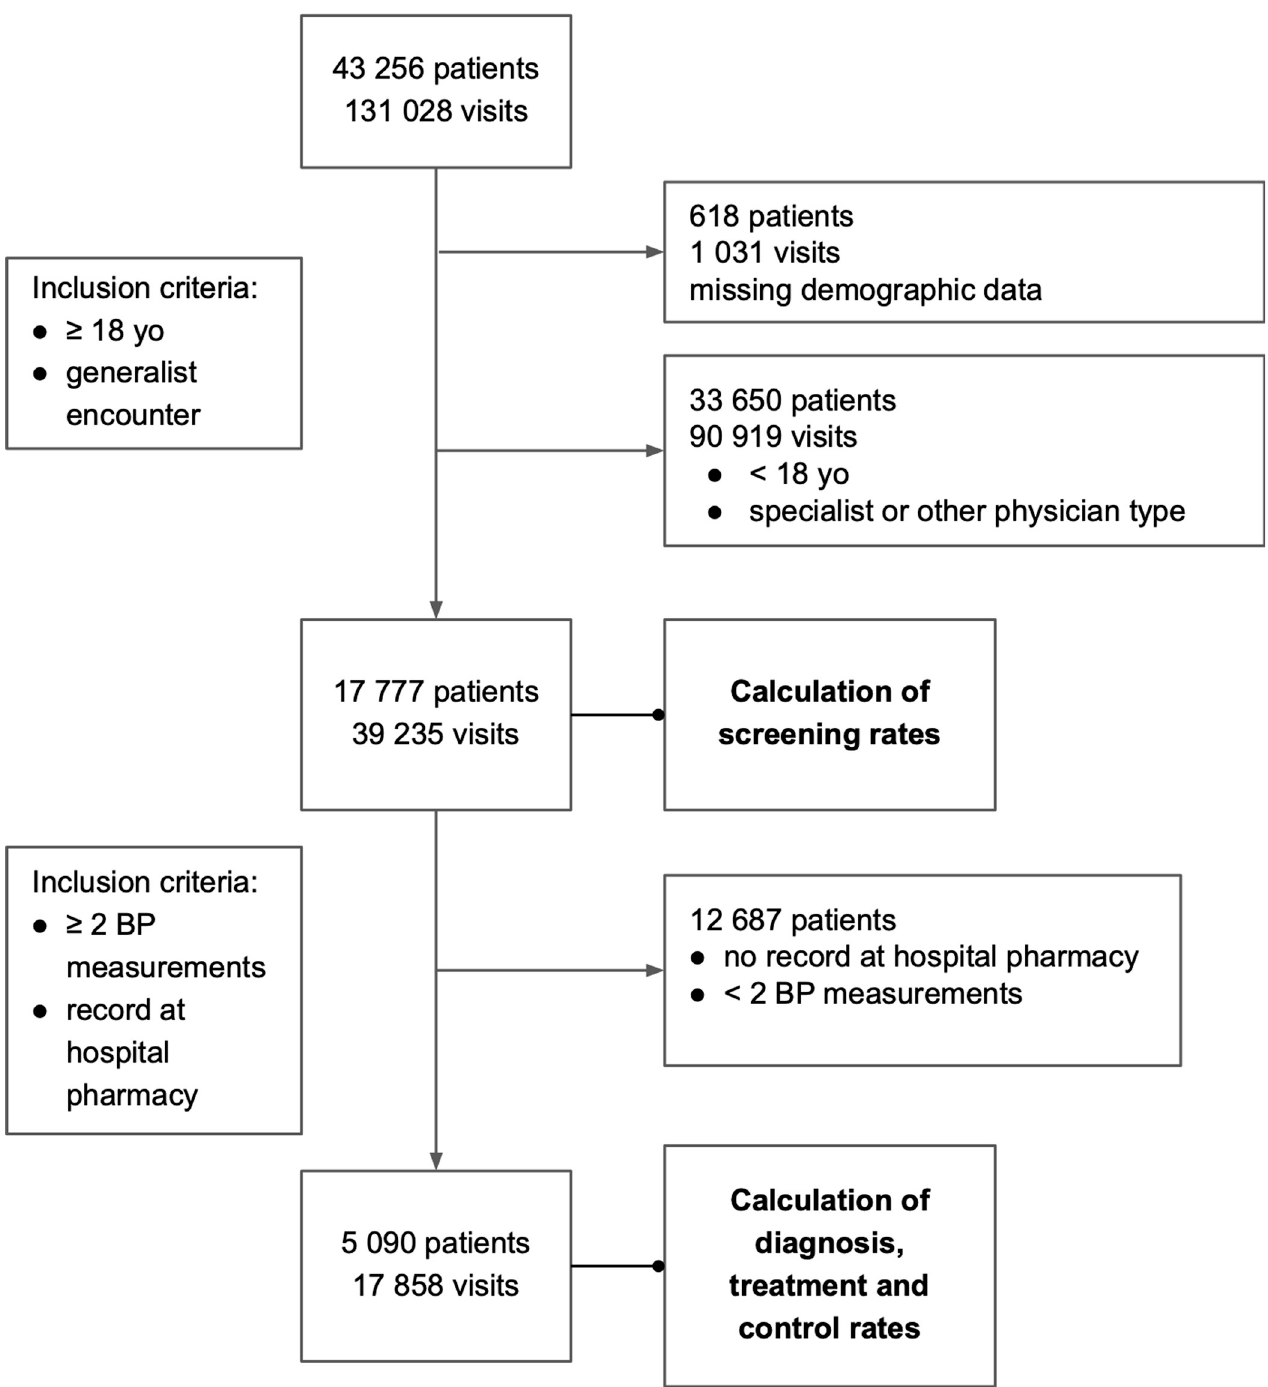
Fig 1. Inclusion and exclusion flowchart. All study members and their inclusion or exclusion from calculation of screening rates, as well as those included or excluded from calculation of prevalence, treatment, and control rates.